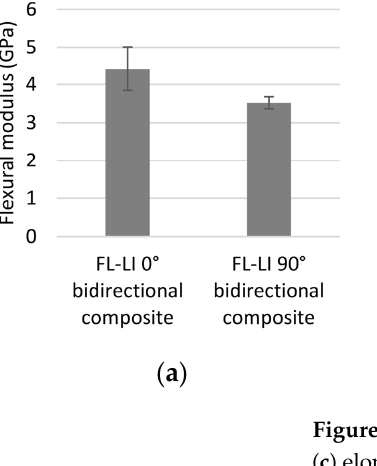
Figure 12. Blue coloured detailed view on the structure of the fracture zones of selected tensile test specimens:( a ) tensile test in weft direction with plastic deformation along the diagonal twill weave lines; ( b ) tensile test in warp direction without plastic deformation.